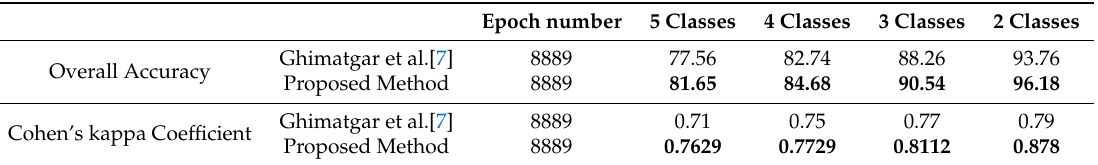
Table 33. The accuracy comparison of the ISRUC3 database with the AASM standard. Highest accuracy in each case is highlighted in